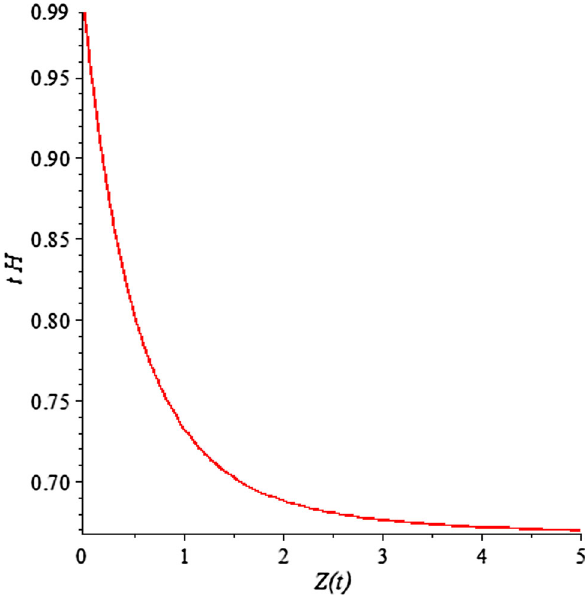
Fig. 4 The Ht versus z plot shows present value H 0 × t 0 = 0 . 99